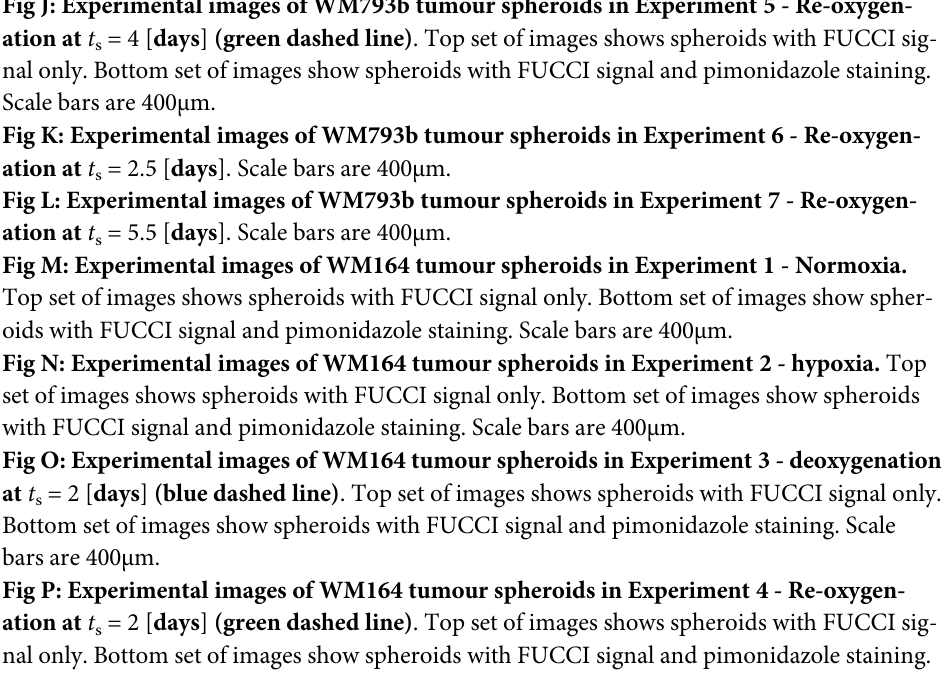
Fig J: Experimental images of WM793b tumour spheroids in Experiment 5 - Re-oxygen- ation at t = 4 [ days ] (green dashed line) . Top set of images shows spheroids with FUCCI sig- s nal only. Bottom set of images show spheroids with FUCCI signal and pimonidazole staining. Scale bars are 400 μ m. Fig K: Experimental images of WM793b tumour spheroids in Experiment 6 - Re-oxygen- ation at t = 2.5 [ days ]. Scale bars are 400 μ m. s Fig L: Experimental images of WM793b tumour spheroids in Experiment 7 - Re-oxygen- = 5.5 [ days ]. Scale bars are 400 μ m. ation at t s Fig M: Experimental images of WM164 tumour spheroids in Experiment 1 - Normoxia. Top set of images shows spheroids with FUCCI signal only. Bottom set of images show spher- oids with FUCCI signal and pimonidazole staining. Scale bars are 400 μ m. Fig N: Experimental images of WM164 tumour spheroids in Experiment 2 - hypoxia. Top set of images shows spheroids with FUCCI signal only. Bottom set of images show spheroids with FUCCI signal and pimonidazole staining. Scale bars are 400 μ m. Fig O: Experimental images of WM164 tumour spheroids in Experiment 3 - deoxygenation at t = 2 [ days ] (blue dashed line) . Top set of images shows spheroids with FUCCI signal only. s Bottom set of images show spheroids with FUCCI signal and pimonidazole staining. Scale bars are 400 μ m. Fig P: Experimental images of WM164 tumour spheroids in Experiment 4 - Re-oxygen- ation at t = 2 [ days ] (green dashed line) . Top set of images shows spheroids with FUCCI sig- s nal only. Bottom set of images show spheroids with FUCCI signal and pimonidazole staining. Scale bars are 400 μ m. Fig Q: Experimental images of WM164 tumour spheroids in Experiment 5 - Re-oxygen- ation at t = 4 [ days ] (green dashed line) . Top set of images shows spheroids with FUCCI sig- s nal only. Bottom set of images show spheroids with FUCCI signal and pimonidazole staining. Scale bars are 400 μ m. Fig R: Experimental images of WM164 tumour spheroids in Experiment 6 - Re-oxygen- ation at t = 2.5 [ days ]. Scale bars are 400 μ m. s Fig S: Experimental images of WM164 tumour spheroids in Experiment 7 - Re-oxygen- ation at t = 5.5 [ days ]. Scale bars are 400 μ m. s Fig T: Image processing to estimate R ( t ) when the FUCCI signal in the central region of n the spheroid is blurred. Images show one WM983b spheroid one day after deoxygenation. Scale bars are 200 μ m. (a) Spheroid with FUCCI signals (green and magenta). (b) Spheroid with FUCCI signals and pimonidazole staining (cyan). (c-e) Blurred region identified using the polygon section tool in ImageJ. Spheroid with: (c) FUCCI-green signal only (green), (d) FUCCI-red signal only (magenta), and (e) pimonidazole staining only (cyan). (f-g) Images in (a) and (b) with blurred region removed. Fig U: Additional experimental measurements comparing spheroids grown in normoxia and hypoxia. (a-b) Estimates of ξ ( t ) = R ( t )/ R ( t ) with n o n time for (a) normoxia and (b) hypoxia. (c-d) Estimates of ξ ( t ) = R ( t )/ R ( t ) with time for (c) i i o normoxia and (d) hypoxia. (e-f) Estimates of ξ ( t ) = R ( t )/ R ( t ) with time for (e) hypoxia and p p o (f) hypoxia. (g-h) Estimates of (g) ξ ( t ), (h) ξ ( t ), and (i) ξ ( t ) with against outer radius, R ( t ). n i p o Fig V: Oxygen diffusion and consumption is sufficient to describe formation and growth of necrotic core but not sufficient to describe formation and growth of inhibited region. Estimates of R (a) per spheroid; (b) with time; (c) against R ( t ). Estimates of α (d) per spher- c o oid; (e) with time; (f) against R ( t ). Estimates of p (g) per spheroid; (h) with time; (i) against o i R o ( t ). In (a-i) each data point represents a single spheroid. Data points are only included for p i if the spheroid is in phase (ii) or phase (iii), consistent with when equations used to estimate p i are